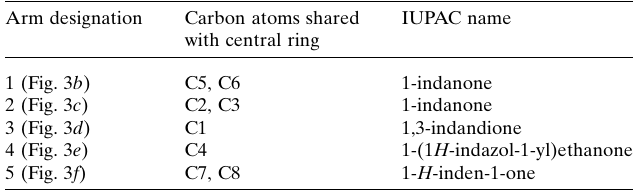
Table 2 The various arms extending from the central ring.